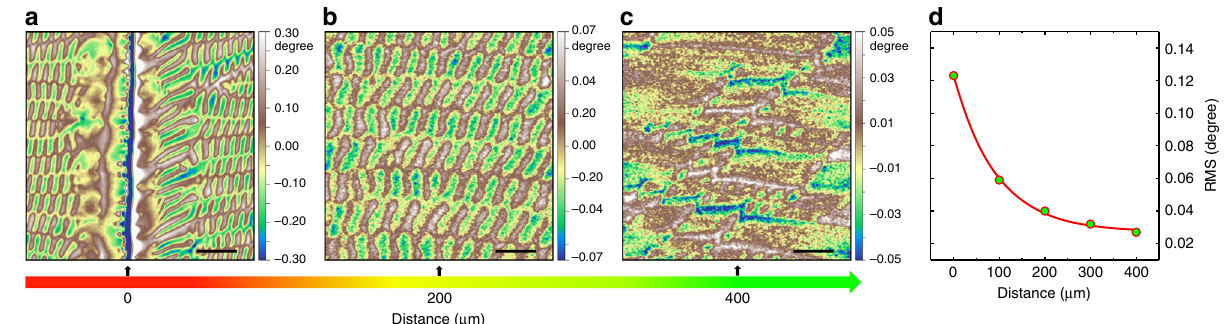
Fig. 3 Ultra-long-range magnetic domain patterns around a single shear band. a , b , c Typical MFM phase images at different distances from the shear band. d Root mean square (RMS) values of the MFM phase shift as a function of the distance from the shear band. Scale bar, 5 µ m in a –